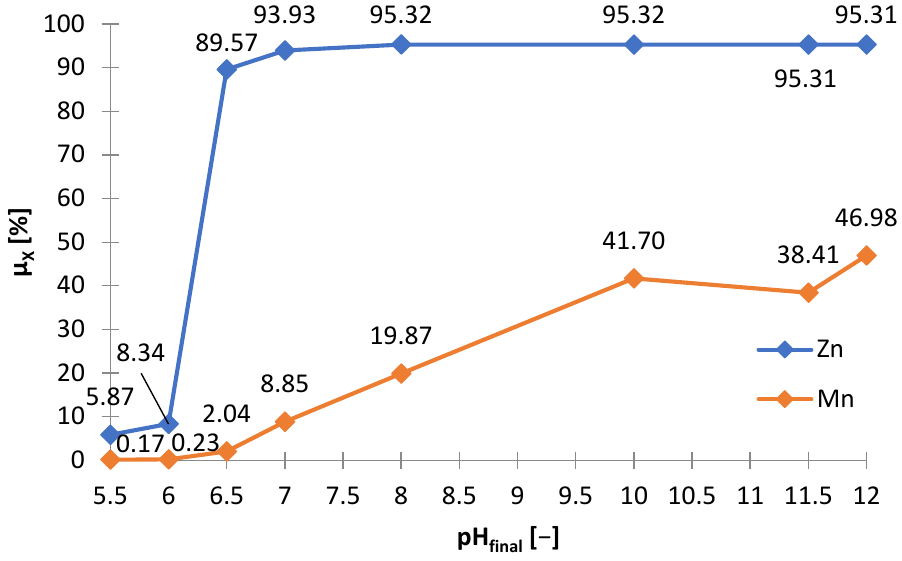
Figure 11. Effect of final pH (pH final ) on amount of precipitate ( ∆ m prec /V sol ) during precipitation by using NaOH from solution after selective leaching.